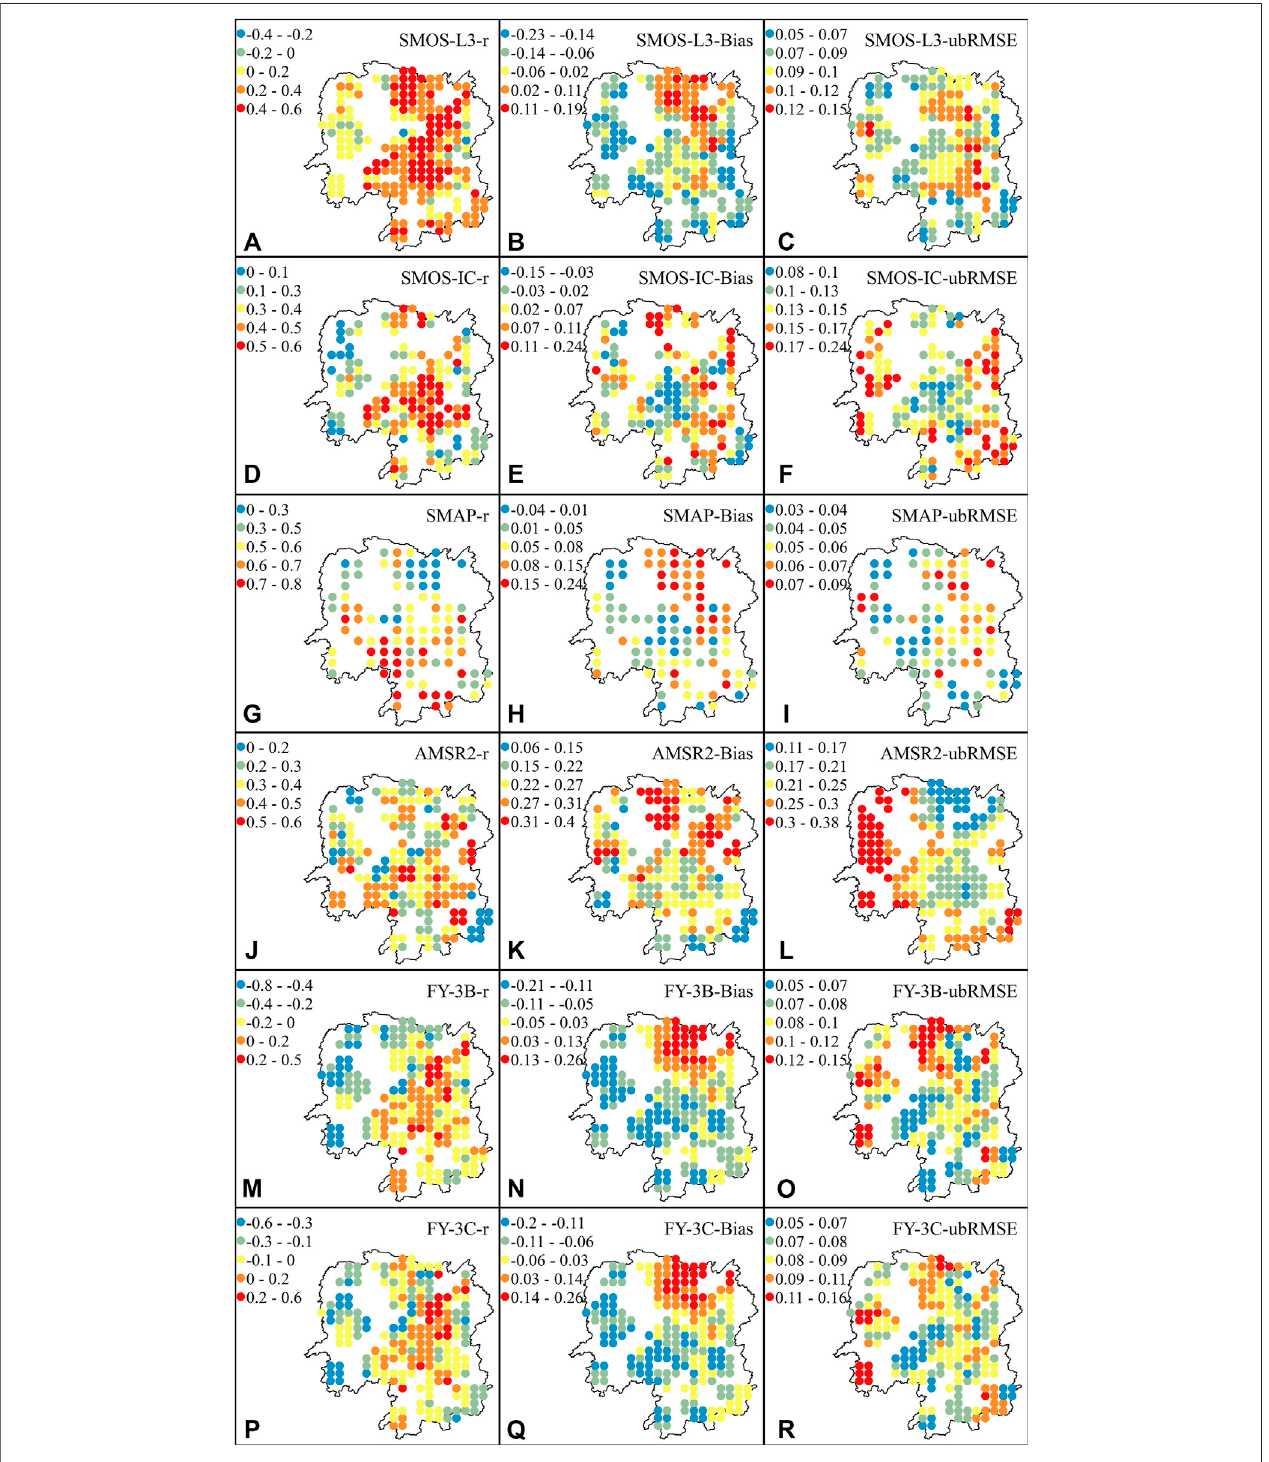
FIGURE 3 | Distribution map of error coef fi cients between remote sensing and in situ measurement data of soil moisture in Hunan province.